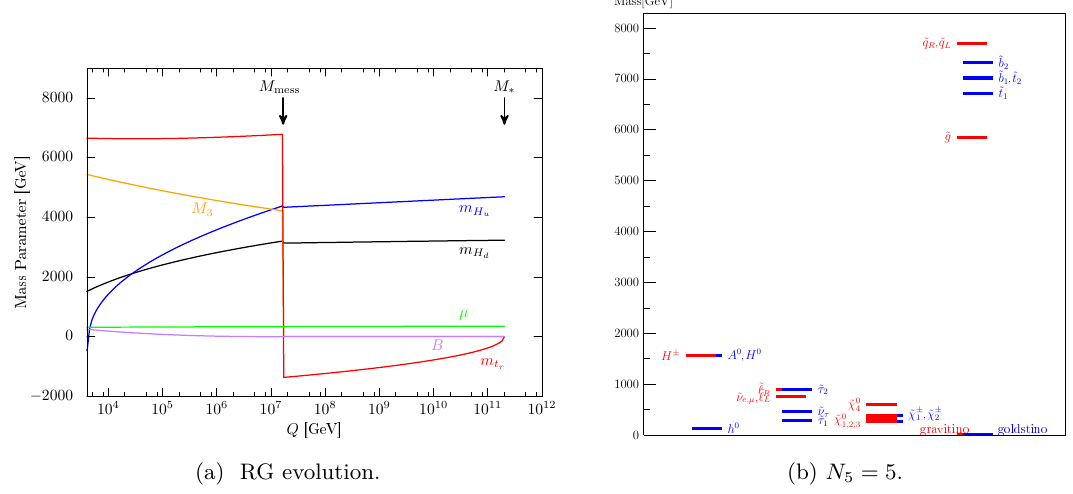
Figure 3. (a): the RG evolution of the SUSY parameters and (b): the mass spectrum of the sample point. We take a sample point of Λ L = 124 TeV, Λ D = 894 TeV, M = 1 . 67 × 10 7 GeV, mess GMSB GMSB ∆ m 2 = 2 . 2 × 10 7 GeV 2 , ∆ m 2 = 1 . 05 × 10 7 GeV 2 and M = 2 × 10 11 GeV, which predicts ∗ H u H d tan β = 41 , m = 124 . 8 GeV and a = 2 . 2 × 10 − 9 µ | SUSY h 0